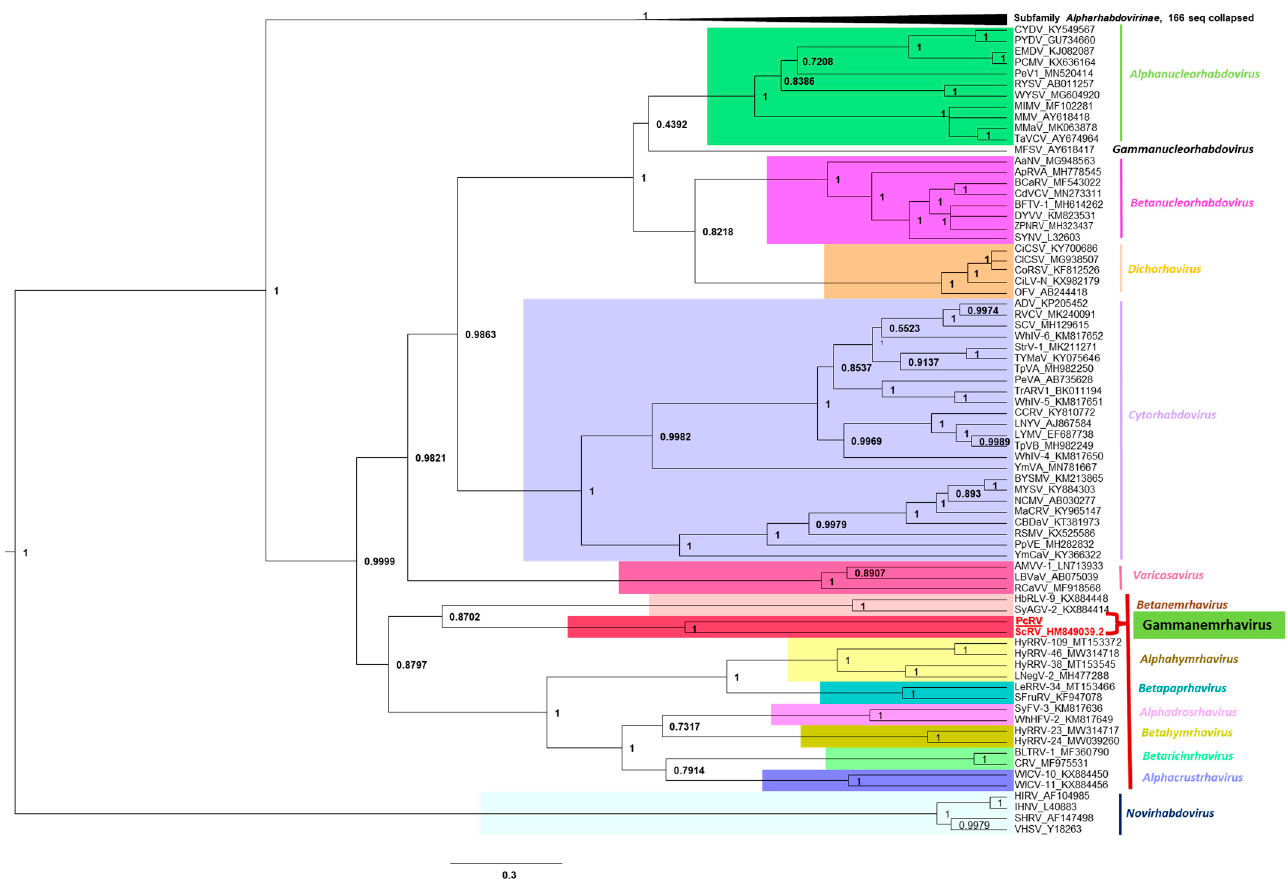
Figure 3. Phylogenetic analysis of full-length amino acid sequences of the rhabdovirus L proteins, with the addition of L-proteins of PcRV and ScRV. Maximum clade credibility (MCC) tree was inferred from MUSCLE alignments as described in Materials and Methods. Branch lengths are drawn to scale, with the scale bar showing the number of substitutions per site.